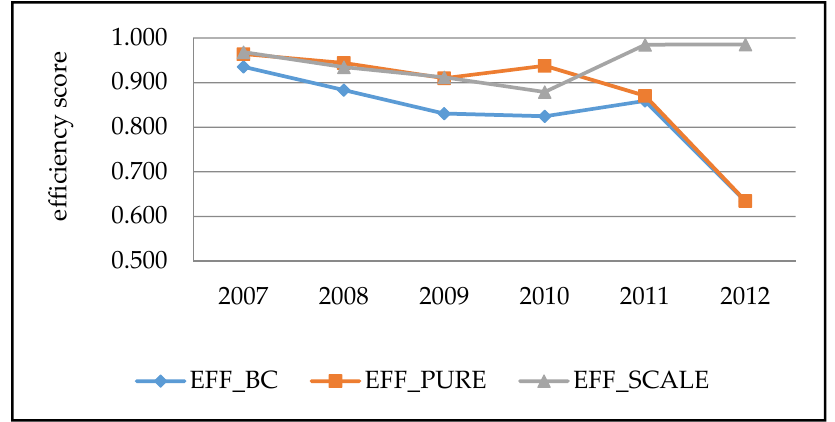
Figure 3. Bias-corrected overall technical efficiency scores and their components in the case of non-GCC Islamic banks (Panel C) during the period 2007–2012.